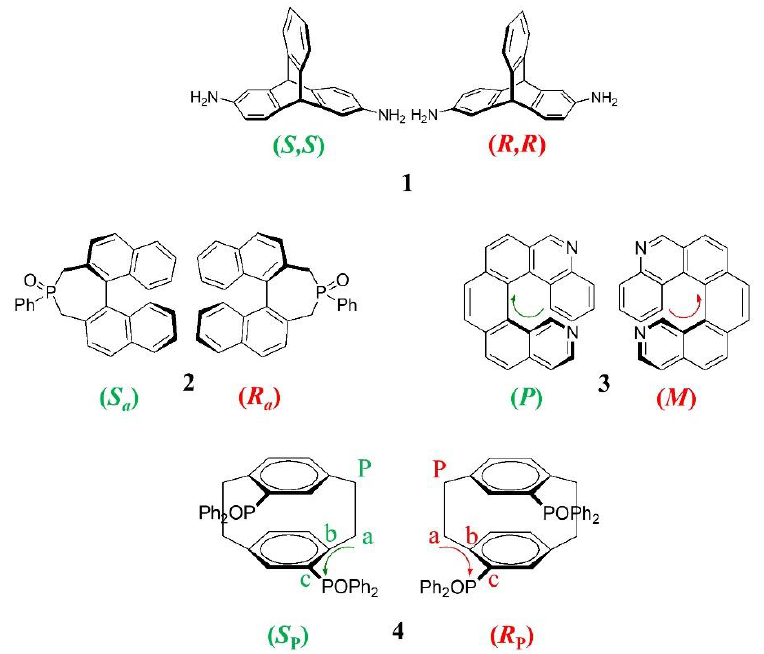
Figure 1. Chemical structures and stereochemical descriptors of enantiomers of chiral compounds 1 – 4 representative of the four stereogenic elements: 1 central stereogenicity, 2 axial stereogenicity, 3 helical stereogenicity, 4 planar stereogenicity.